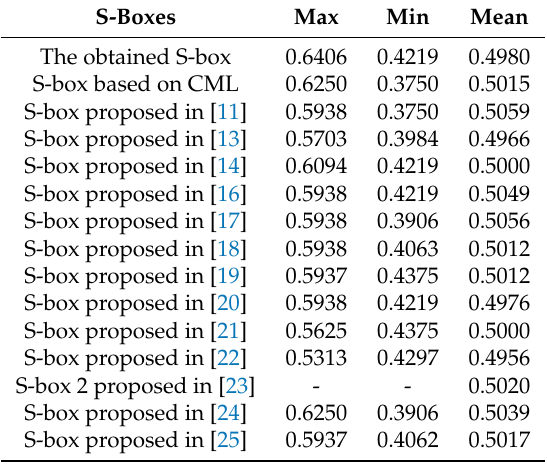
Table 5. The Strict Avalanche Criterion (SAC) analysis of different